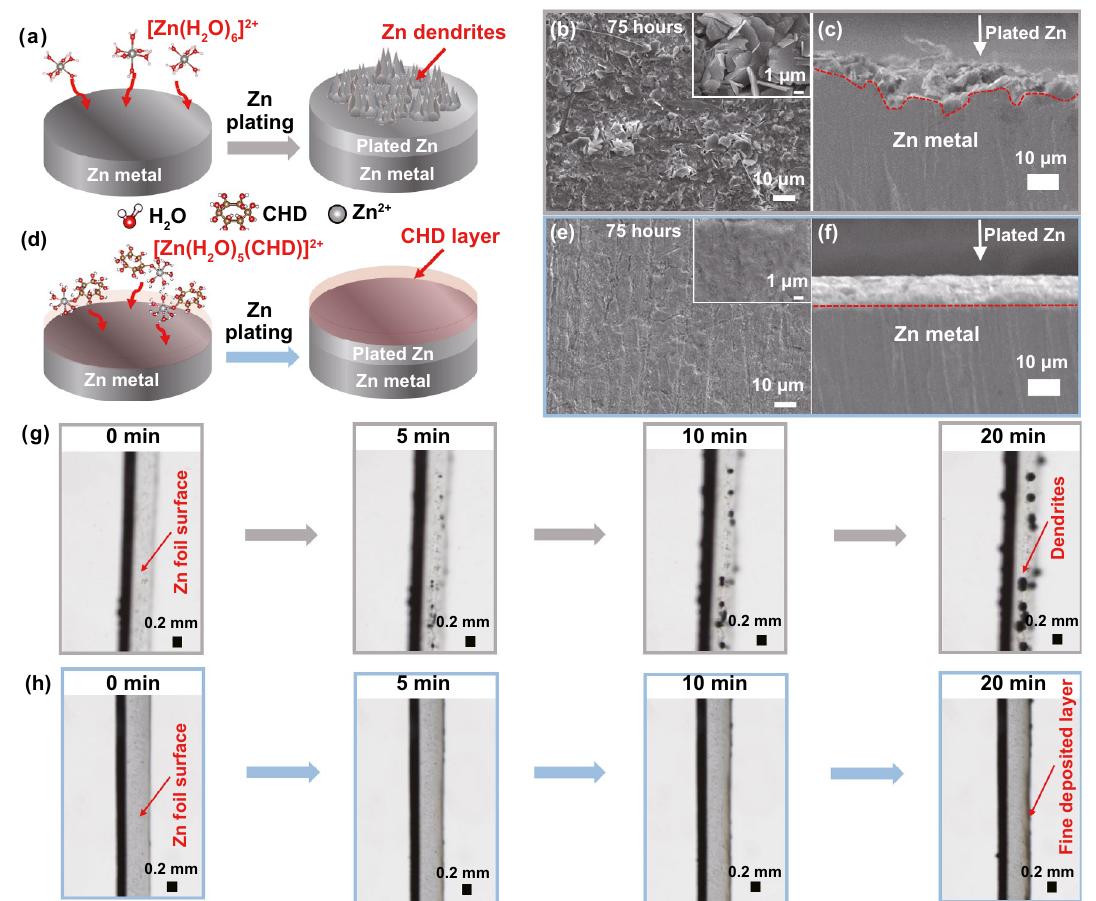
Fig. 2 a–f Schematic figure of Zn plating process and the corresponding SEM images on Zn foil at 2 mA cm −2 and 1 mAh cm −2 for 75 h in Zn|Zn cells under ZnSO 4 ( a–c ) and CHD‑assisted ZnSO 4 electrolytes ( d–f ), respectively. g–h In situ optical microscopy images of the Zn depo‑ sition process using ZnSO 4 ( g ) and CHD‑assisted ZnSO 4 electrolyte ( h